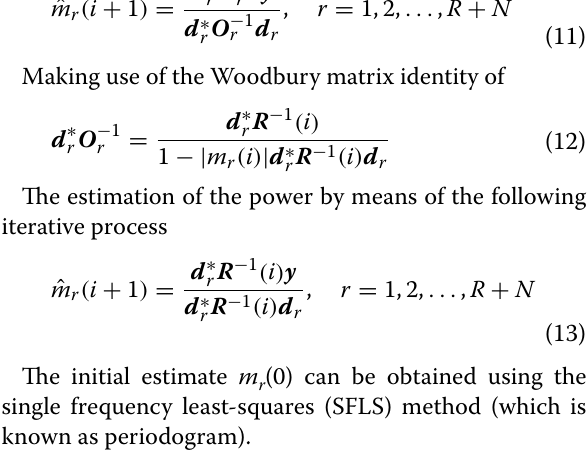
Fig. 1 Spectrum of the original signal